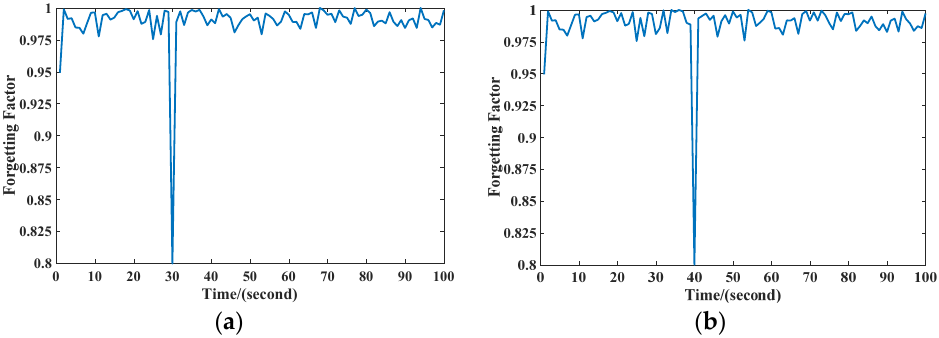
Figure 7. Value of the forgetting factor: ( a ) scenario 1, ( b ) scenario 2.